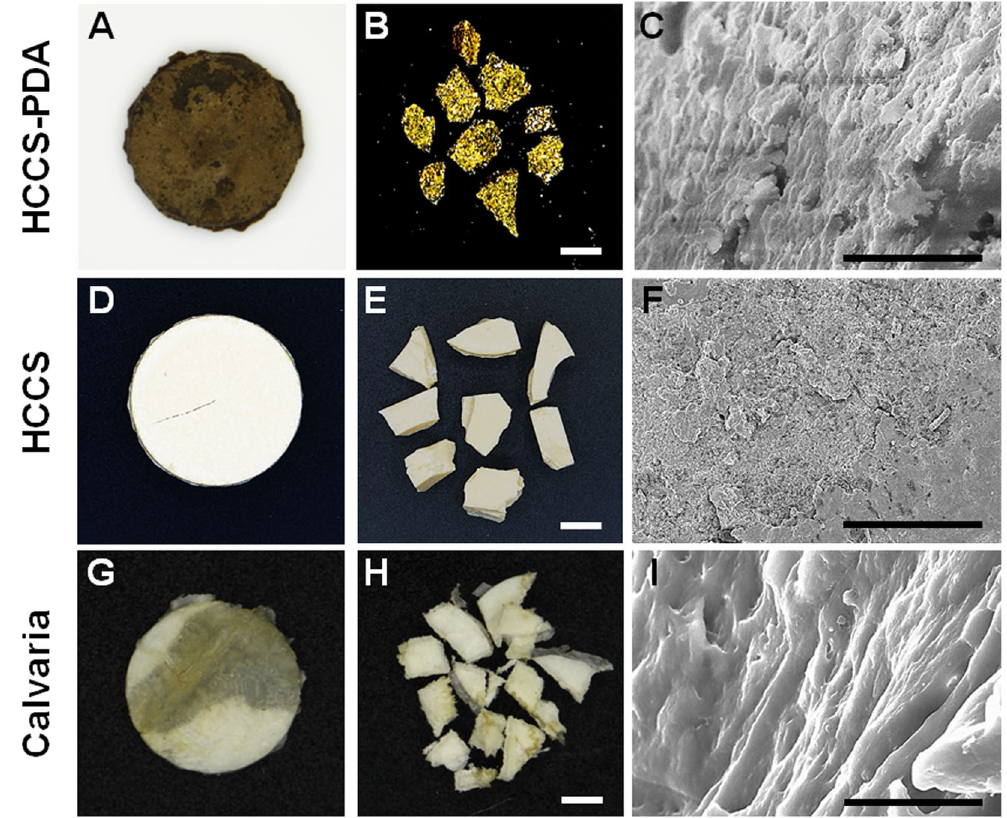
Figure 2. Representative gross images of HCCS-PDA, HCCS, and calvaria disk samples ( A , D , G ) and particulate forms ( B , E , H ), scale: 2500 μ m. Scanning electron microscopy images of each particulate’s cross- sectional view ( C , F , I ), scale: 10 μ m. The disk dimensions are 16.5 mm in diameter and 2 mm in